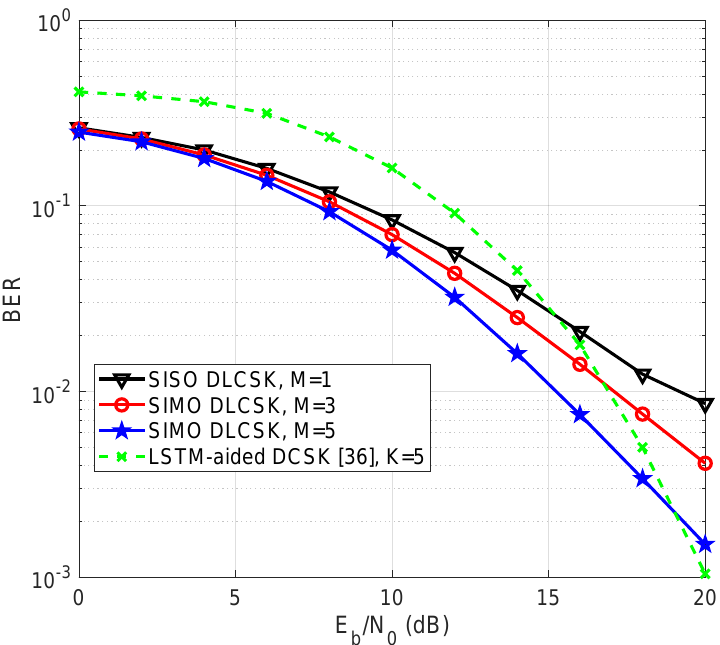
Figure 11. BER curve of the SIMO DLCSK under Rayleigh fading channel, for β = 50, in comparison with the LSTM-aided OFDM DCSK [40], for K =